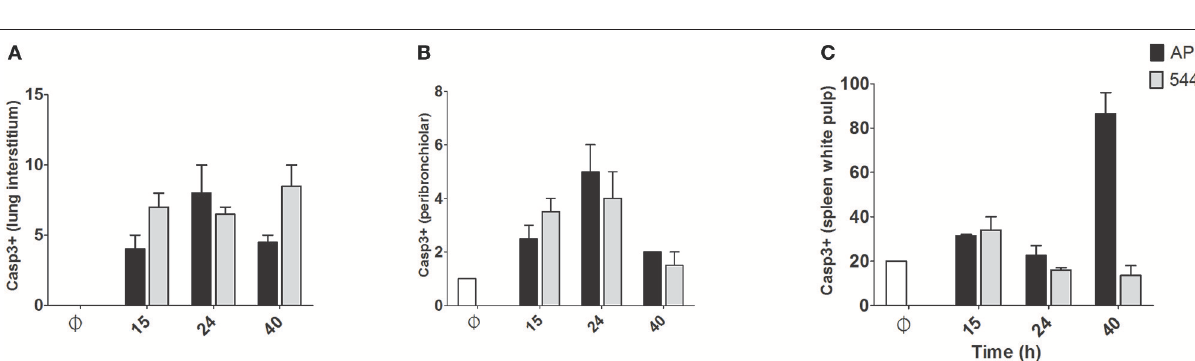
infection with either strain ( Figure 6E ). When expressing the abundances of the various leukocyte types as relative values, i.e., percentages of WBC count, the same tendencies were observed, but the differences in lymphocyte and granulocyte percentages between AP1 and 5448 infection at 6 h p.i. and 40 h p.i. were even more pronounced (data not shown due to space limitation). Platelet counts decreased gradually